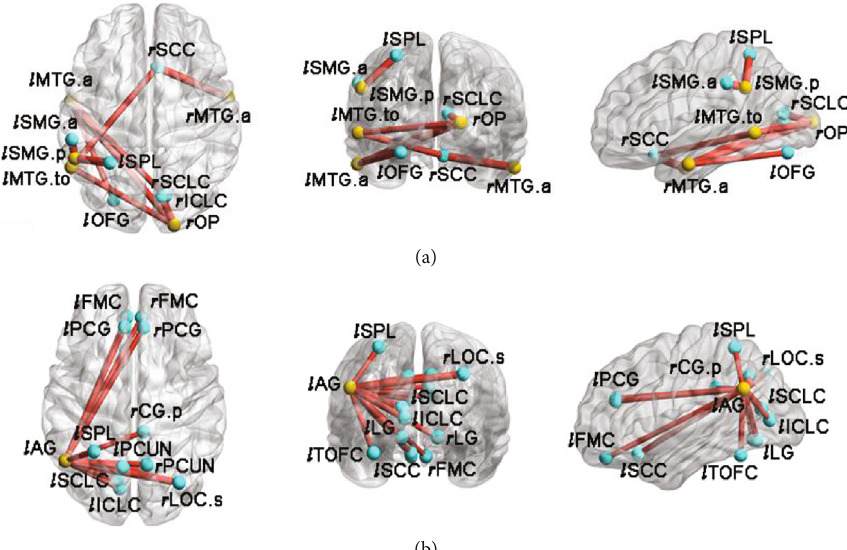
Figure 5: ROI-wise FC patterns with signi fi cant alterations between the L-SSNHL and HC-1 subgroups. Compared with the HC-1 subgroup, the L-SSNHL subgroup showed signi fi cantly increased FCs between the bilateral MTG and ROIs mainly located in the bilateral occipital lobes and the right limbic lobe, and between the l SMG.p and the left parietal cortex (a). Increased FCs were observed between the l AG and ROIs, mainly located in the bilateral frontal lobes, occipital lobes, and limbic lobes (b). The yellow balls indicate the seed ROI while the cyan balls indicate the ROIs with signi fi cantly di ff erent FC values. MTG: middle temporal gyrus; OP: occipital pole; SMG: supramarginal gyrus; AG: angular gyrus; ICLC: intracalcarine cortex; OFG: occipital fusiform gyrus; SCC: subcallosal cortex; SCLC: supracalcarine cortex; SPL: superior parietal lobule; LOC: lateral occipital cortex; FMC: frontal medial cortex; PCG: paracingulate gyrus; CG: cingulate gyrus; PCUN: precuneus; LG: lingual gyrus; TOFC: temporal occipital fusiform cortex; l : left; r : right; a: anterior division; p: posterior division; s: superior division; to: temporooccipital